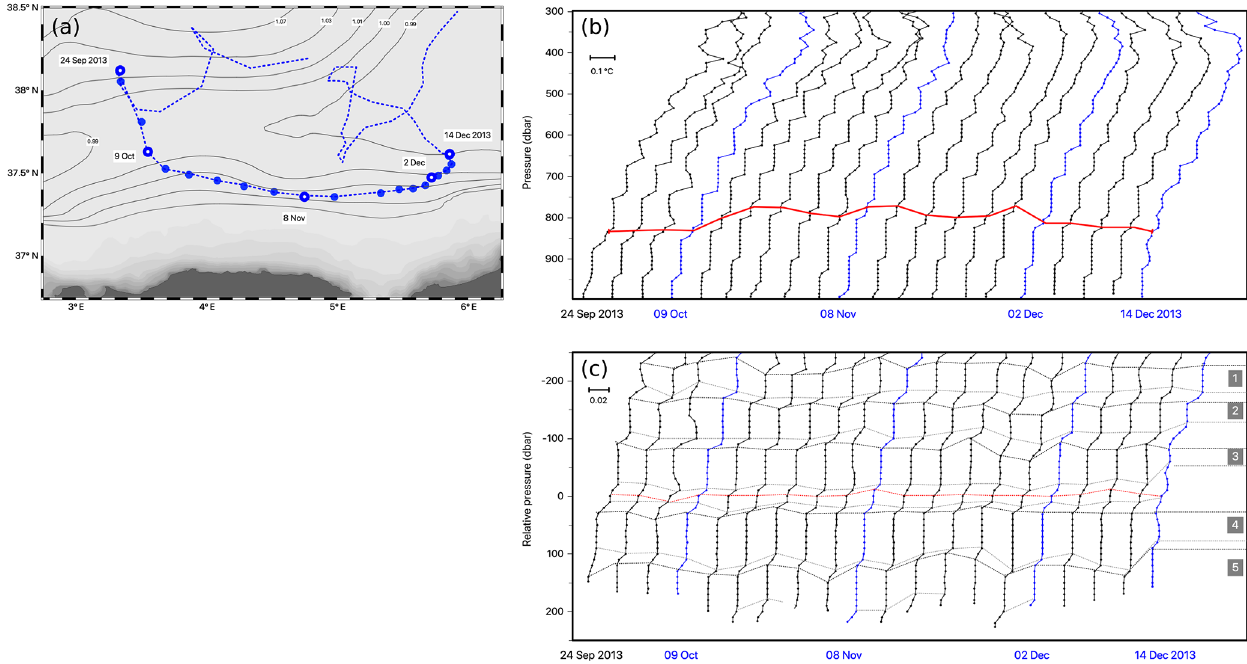
Figure 10. Drift trajectory (a) and successive profiles of temperature (b) and salinity (c) collected by float 6901513 between 24 Septem- ber 2013 and 14 December 2013, with a vertical resolution of 10dbar. Temperature profiles are shifted by 0.1 ◦ C, salinity profiles by 0.02. Values on the y axis correspond to the pressure referenced to the surface (b) or to the relative pressure referenced to the interface 3/4 indicated by the red line (c) .